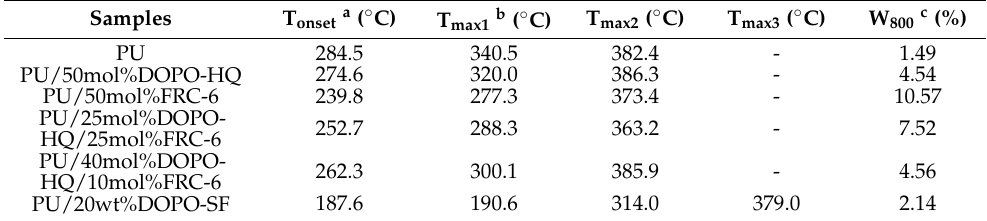
Figure 2. TG (a) and DTG (b) curve of PU, PU/DH, PU/F, PU/DH/F and PU/DS. Table 3. Thermal decomposition characteristics of PU, PU/DH, PU/F, PU/DH/F and PU/DS. Samples